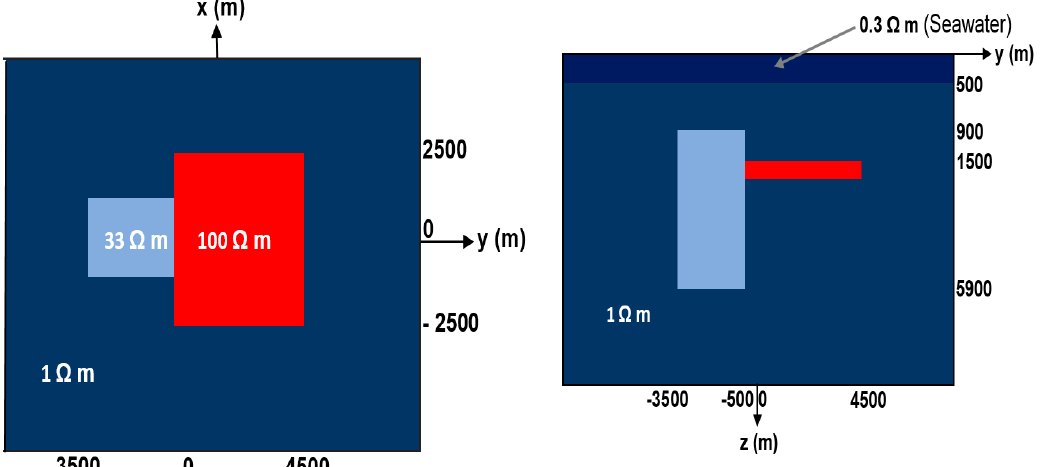
Figure 4. The planar and vertical cross-section view of the marine model 2. The anomalous bodies are embedded in a homogenous layer below the sea water.